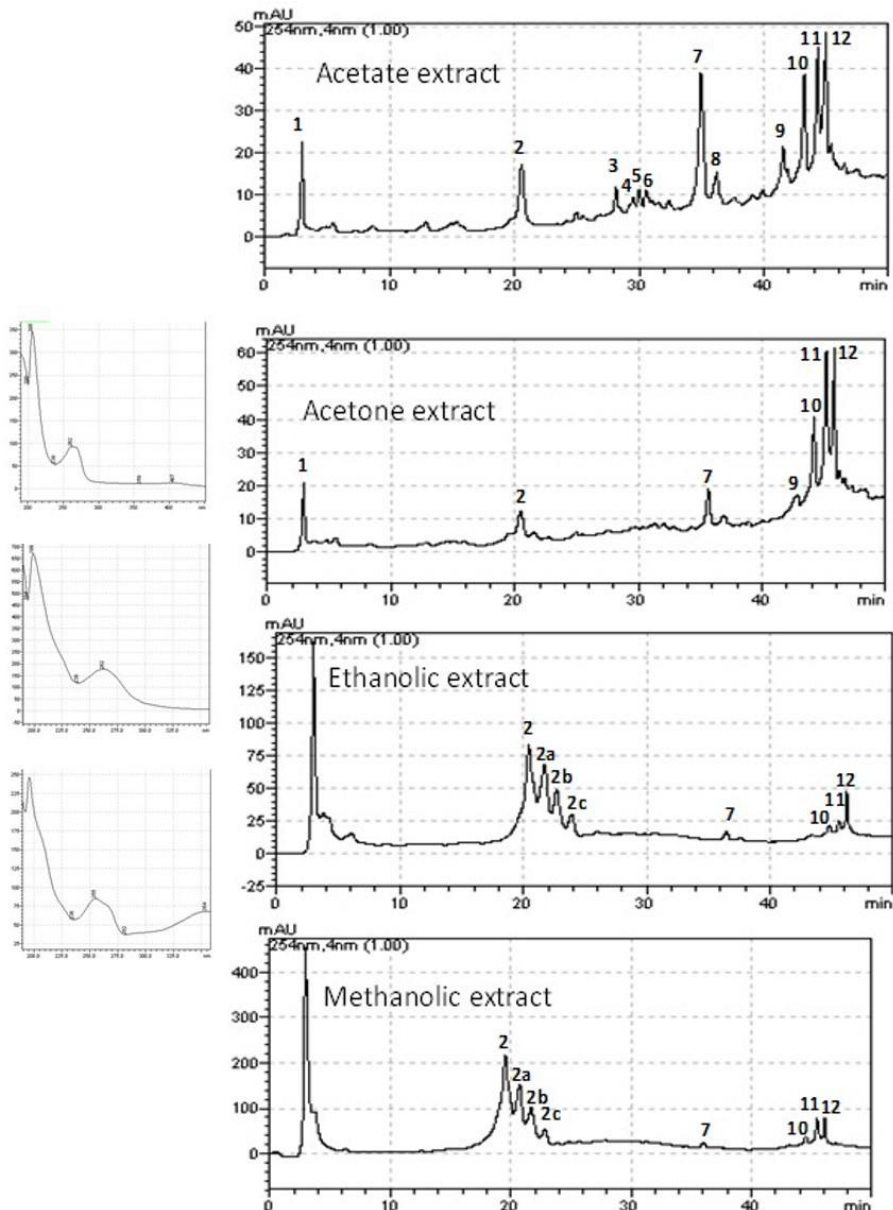
Figure 1. Typical chromatogram obtained by HPLC-PDA analysis (254 nm) of the EE, ME, AE and EAE of M. linifera . Table 1. UV-Vis data of the chromatographic peaks of the extract and fractions obtained from M. linifera.